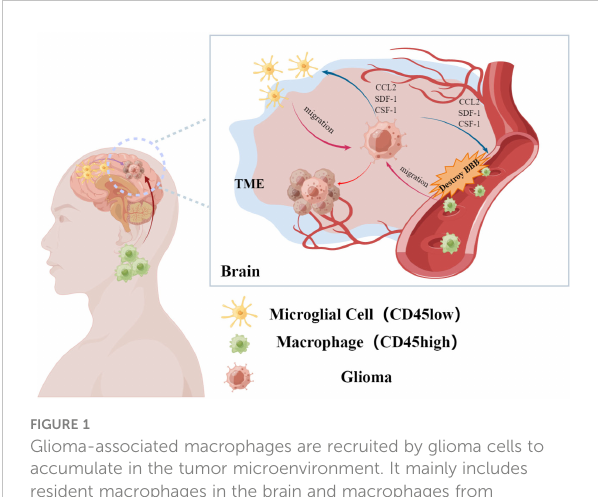
FIGURE 1 Glioma-associated macrophages are recruited by glioma cells to accumulate in the tumor microenvironment. It mainly includes resident macrophages in the brain and macrophages from peripheral sources, which affect the malignant process of glioma. (By Figdraw).